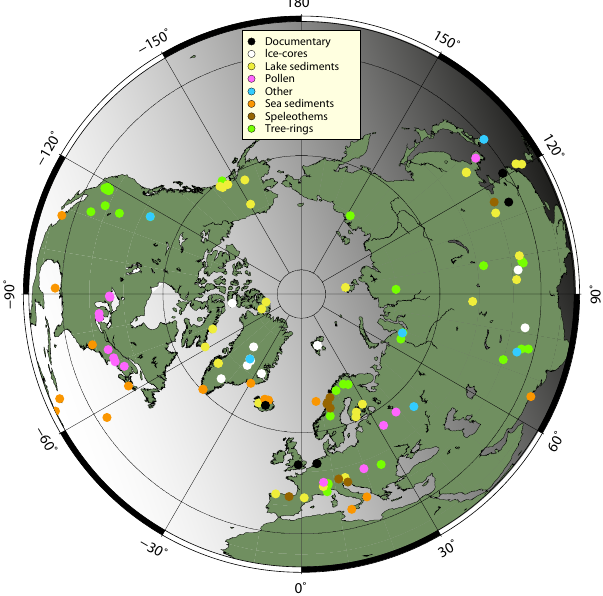
Fig. 1. Type and location of all 120 proxy records used in this study (see Table 1 for details). Note, that a few pairs of proxies share the same geographical position but are based on different archives. Not depicted on this map is the Indo-Pacific Warm Pool sea sediment record located at latitude 3.53 ◦ S and longitude 119.27 ◦